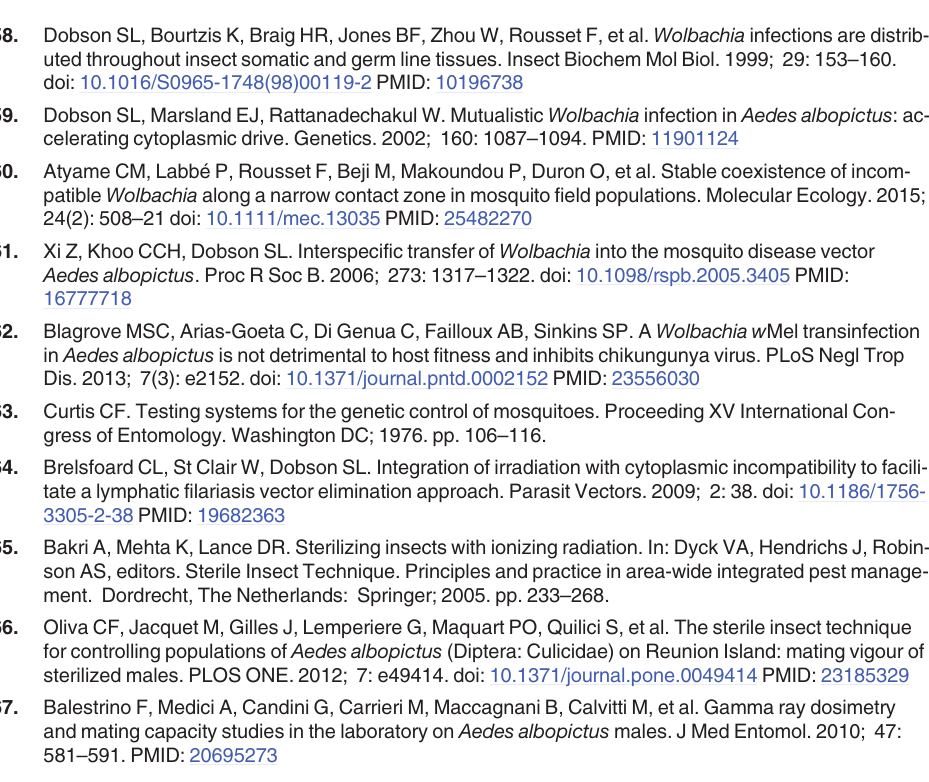
PLOS ONE | DOI:10.1371/journal.pone.0121813 March 26,